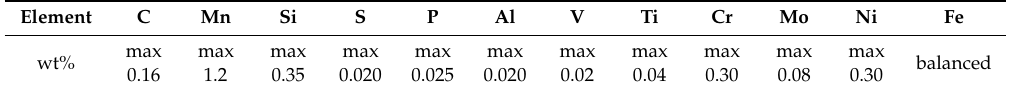
Table 1. Chemical composition for steel P 235 TR 1.